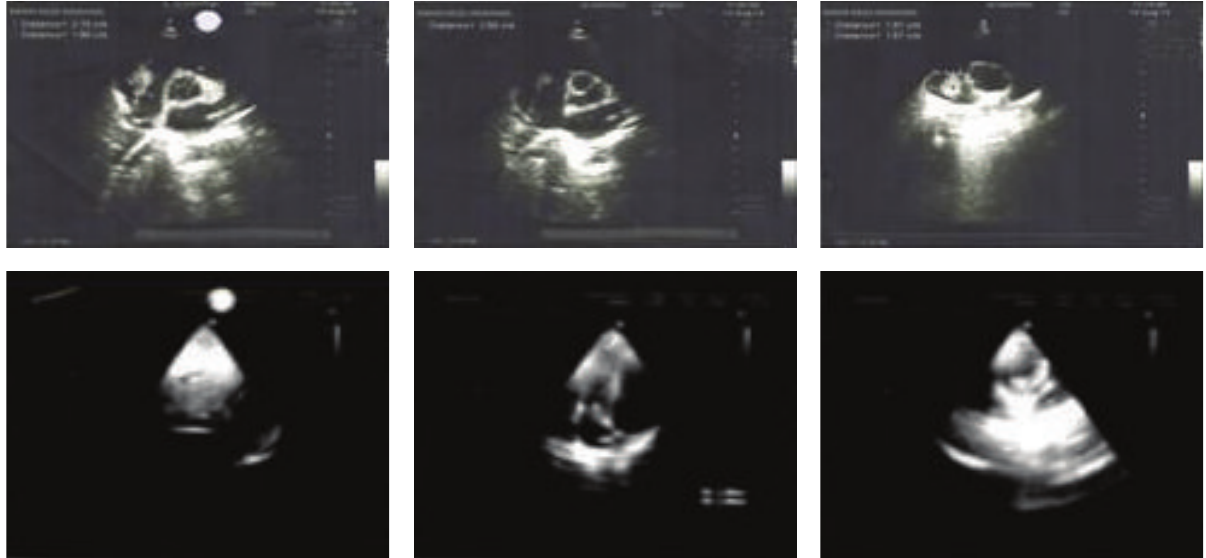
Figure 1: Transesophageal echocardiography (TEE) of a right atrial mass in the patient.